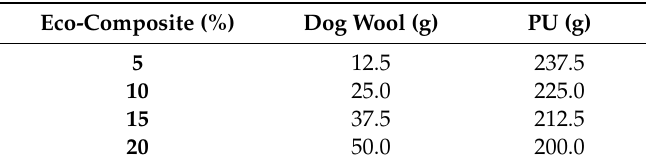
Figure 1. ( a ) Fiber microparticles, ( b ) mixture of PU resin and the fiber microparticles, and ( c ) the eco-composite. Table 1. Eco-composites’ composition.